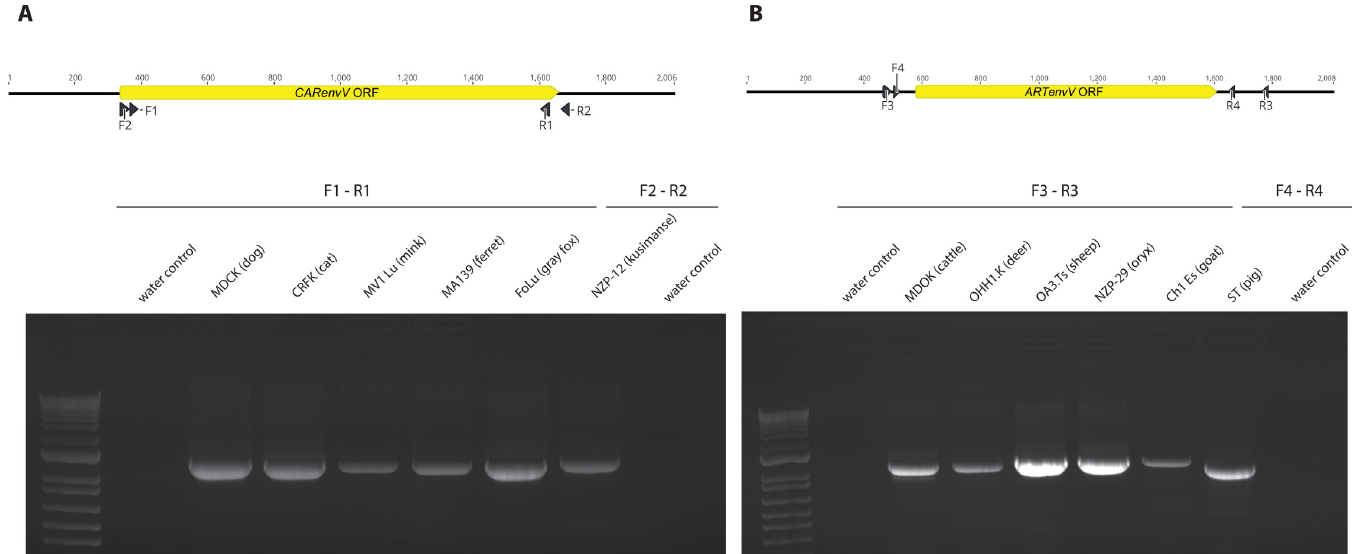
Fig 10. CARenvV and ARTenvV expression in Artiodactyla and Carnivora cell lines. A. and B. At the top is a schematic of the genomic region that contains A. CARenvV ORF or B. ARTenvV ORF with the locations of the primers used for RT-PCR indicated below the diagram. Below are the agarose gels showing the RT-PCR products of A. CARenvV and B. ARTenvV that were amplified from the total RNA of the indicated species with the primers shown in the upper panel. The gels shown are representative of at least two independent